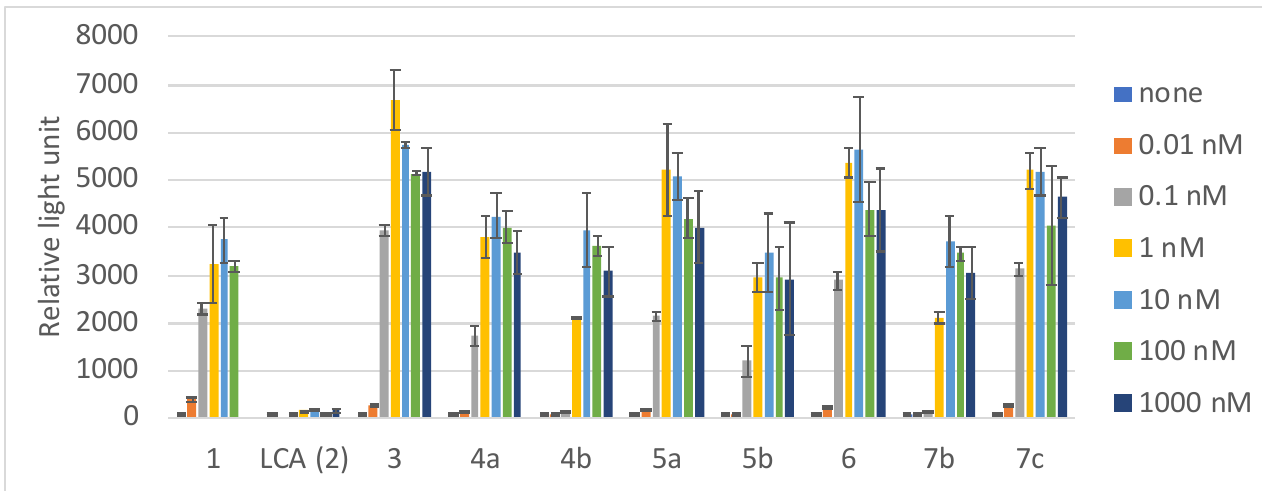
Figure 4. VDR transactivation ability of lithocholic acid amide derivatives in HEK293 cells. Table 1. EC 50 vales of novel lithocholic acid amide derivatives.